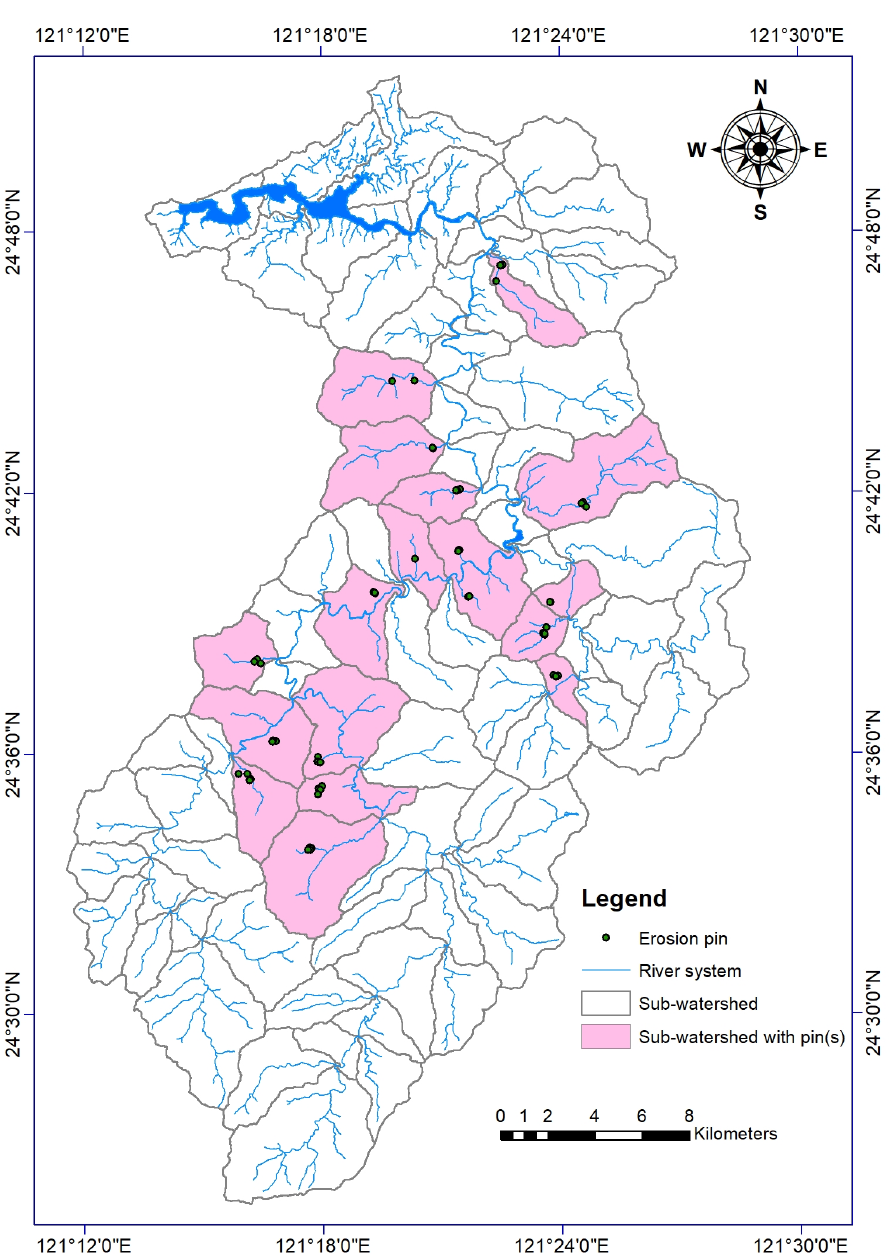
Figure 1. The study area of the Shihmen Reservoir watershed.